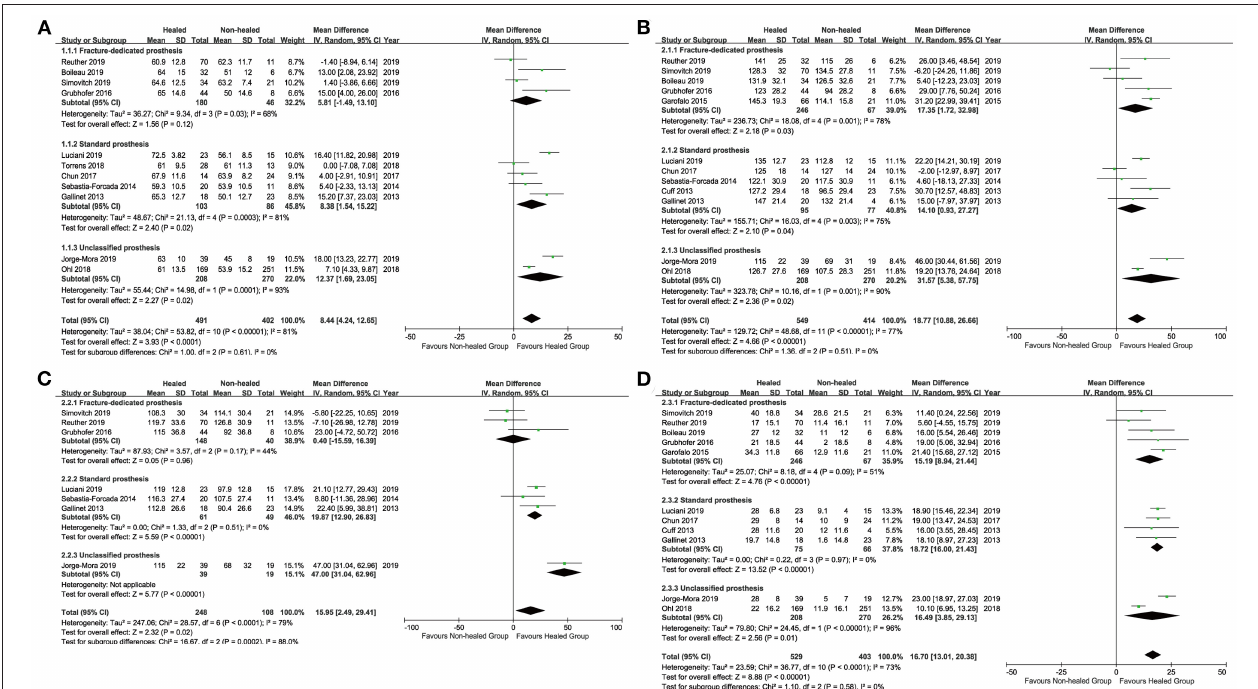
FIGURE 3 | Subgroup analysis for the Constant score, flexion, abduction, and external rotation between the healed groups and the non-healed groups. (A) : the Constant score, (B) : flexion, (C) : abduction, and (D) : external rotation.